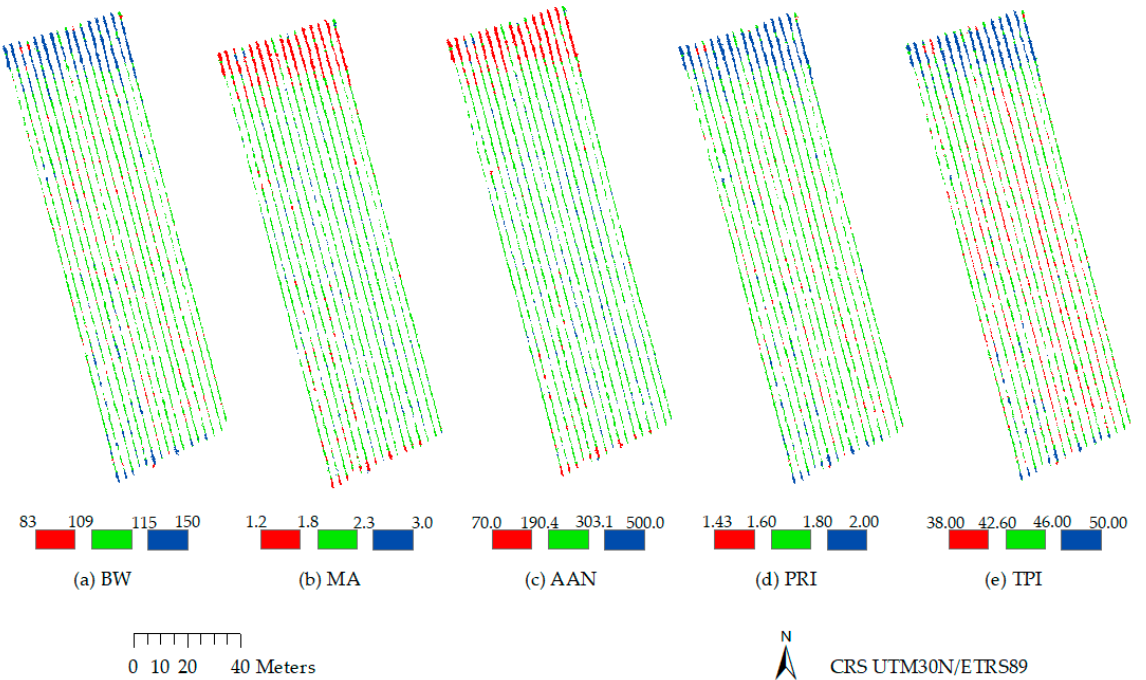
Figure 6. Spatial variability maps of must quality variables. ( a ) BW with RGBVI2, ( b ) MA with VARI, ( c ) AAN with VARI, ( d ) PRI with VARI, and ( e ) TPI with RGBVI3. The maps were classified in red, green and blue categories (low, intermediate and high values, respectively) using the natural breaks classification method. BW: 100-berry weight (kg · 10 − 3 ); MA: malic acid (g/L); AAN: alpha amino nitrogen (mg/L); PRI: phenolic ripeness index; and TPI: total phenolic index.